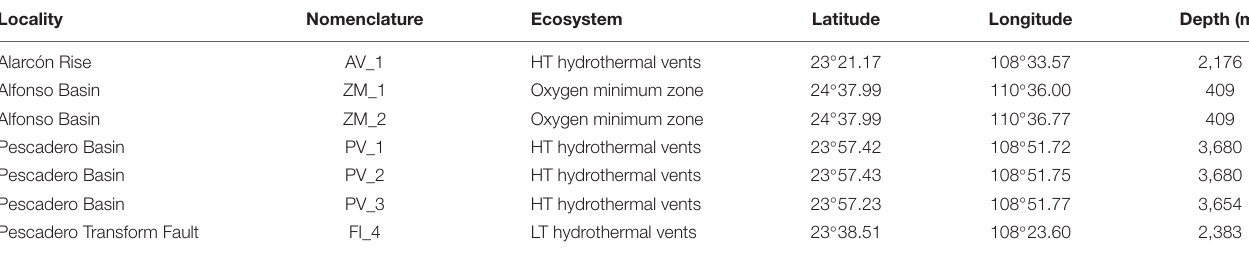
TABLE 1 | Sampling stations where sediment cores were collected in the southern Gulf of California,